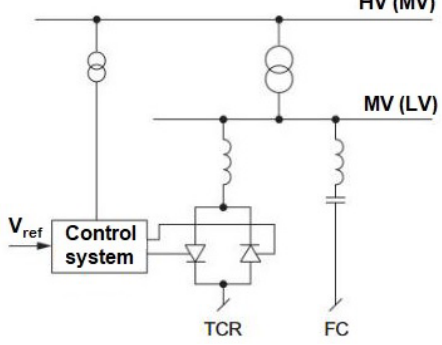
Figure 31. Schematic diagram of the static compensator system [35].